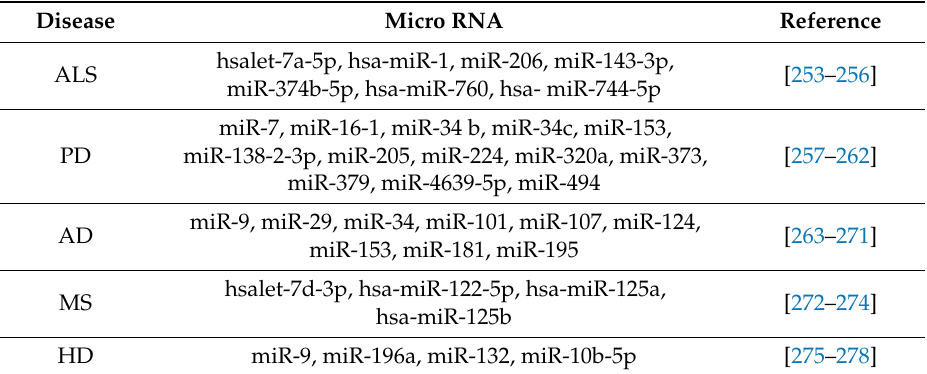
Table 2. Neurodegenerative diseases and their association with